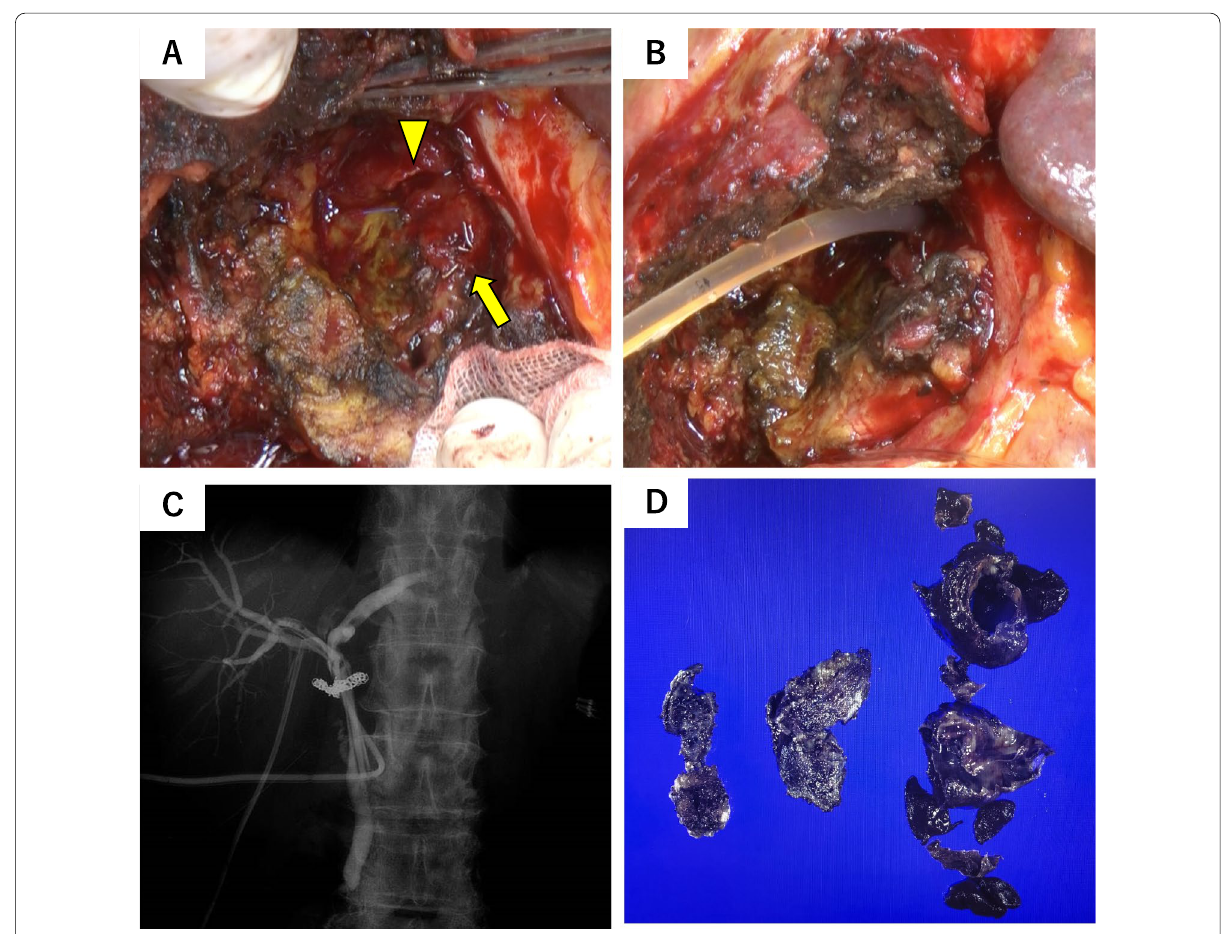
Fig. 3 Intraoperative images, cholangiogram, and macroscopic findings of the resected gallbladder. Intraoperative image: the coil used for embolization of the right hepatic artery was observed in the neck of the gallbladder ( A : yellow arrow). The biliobiliary fistula was also observed ( A : yellow arrowhead). A T-tube was inserted into the common bile duct from the fistula ( B ). Cholangiogram: the peripheral bile ducts were visualized and no leakage from the bile ducts was observed ( C ). The exact size of the gallbladder could not be determined because it was resected as much as possible. The gallbladder wall was clearly thickened, with edema, fibrosis, and granulomatous changes. No malignant findings were observed ( D